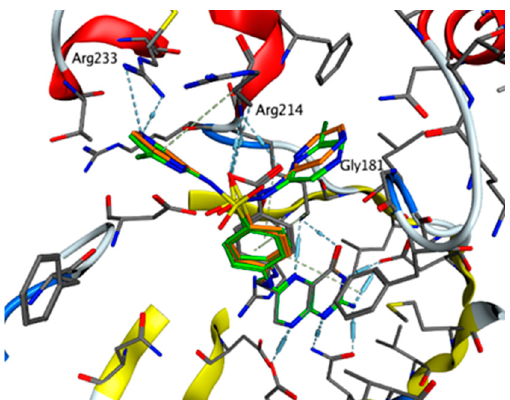
Figure 6. Product of 4a (orange) and product of 4b (green) main poses from the docking experiments. The pose of 7,8-dihydropteroate (grey) corresponds to the experimentally determined position seen in bacterial DHPS [e.g., Burkholderia cenocepacia DHPS (PDB ID: 2y5s) or Bacillus anthracis DHPS (PDB ID: 3tya)].